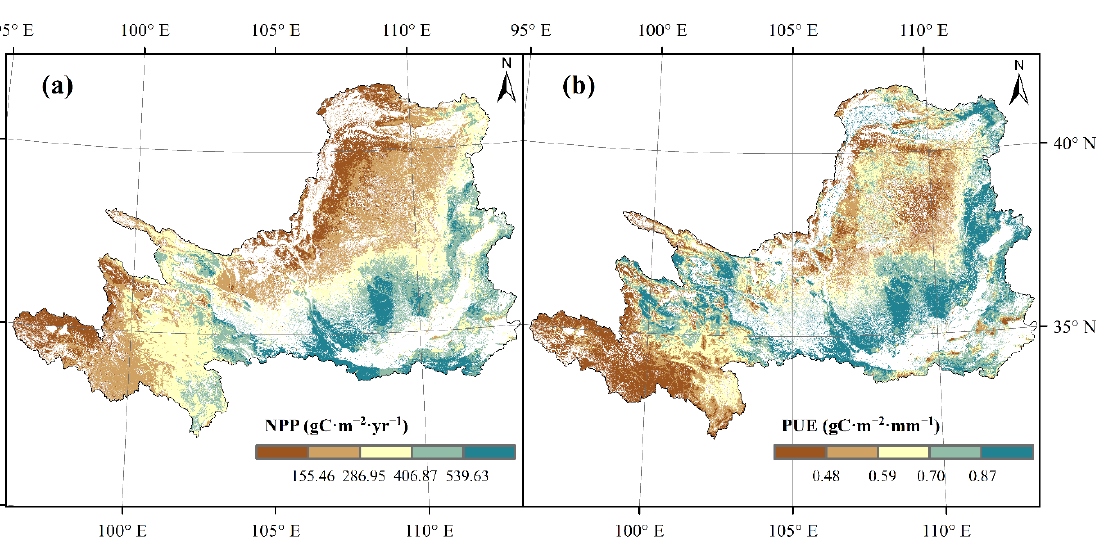
Table 1. The spatial mean, maximum, minimum, coefficient of variation(CV) of the forest, shrub land, grassland NPP and PUE, and the spatial average MAP(MAP avg ) in their respective distribution areas.